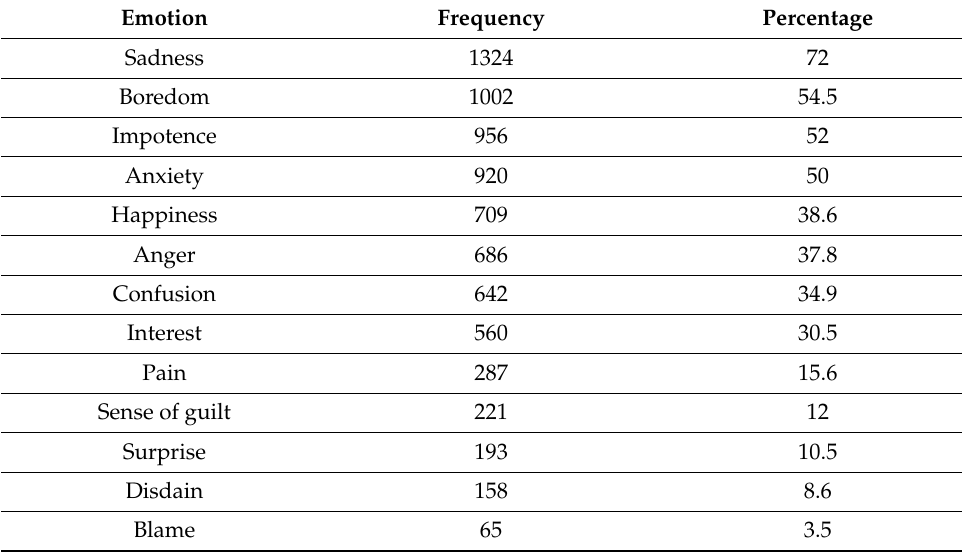
Table 5. Descriptive analyses of emotions felt by participants in the last